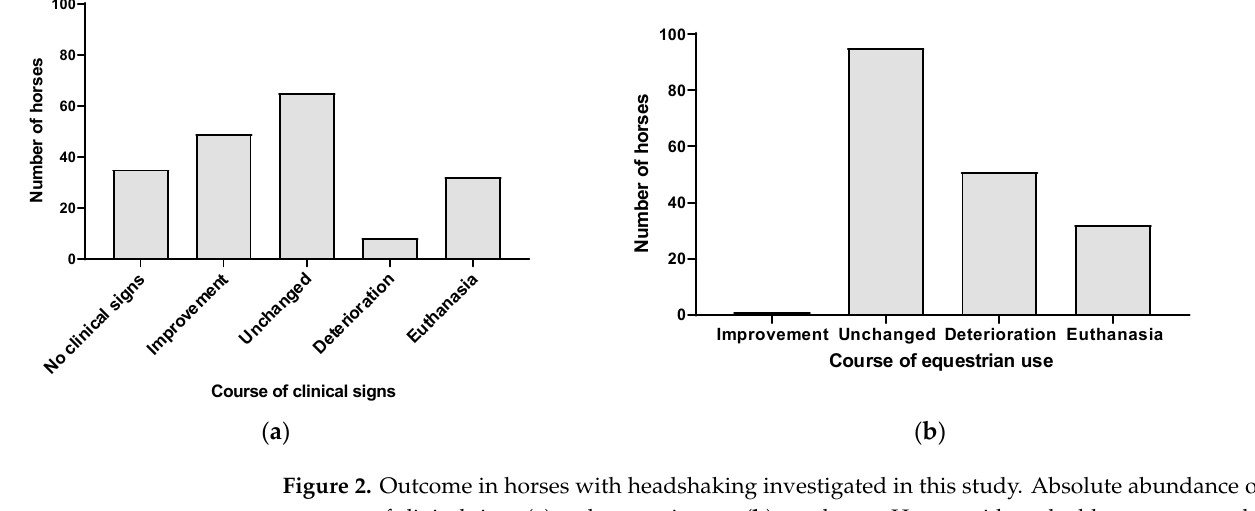
Figure 2. Outcome in horses with headshaking investigated in this study. Absolute abundance of outcome of clinical signs ( a ) and equestrian use ( b ) are shown. Horses with evaluable outcomes and a diagnosis of idiopathic trigeminal-mediated headshaking, suspected idiopathic trigeminal-mediated headshaking, and secondary headshaking are included.